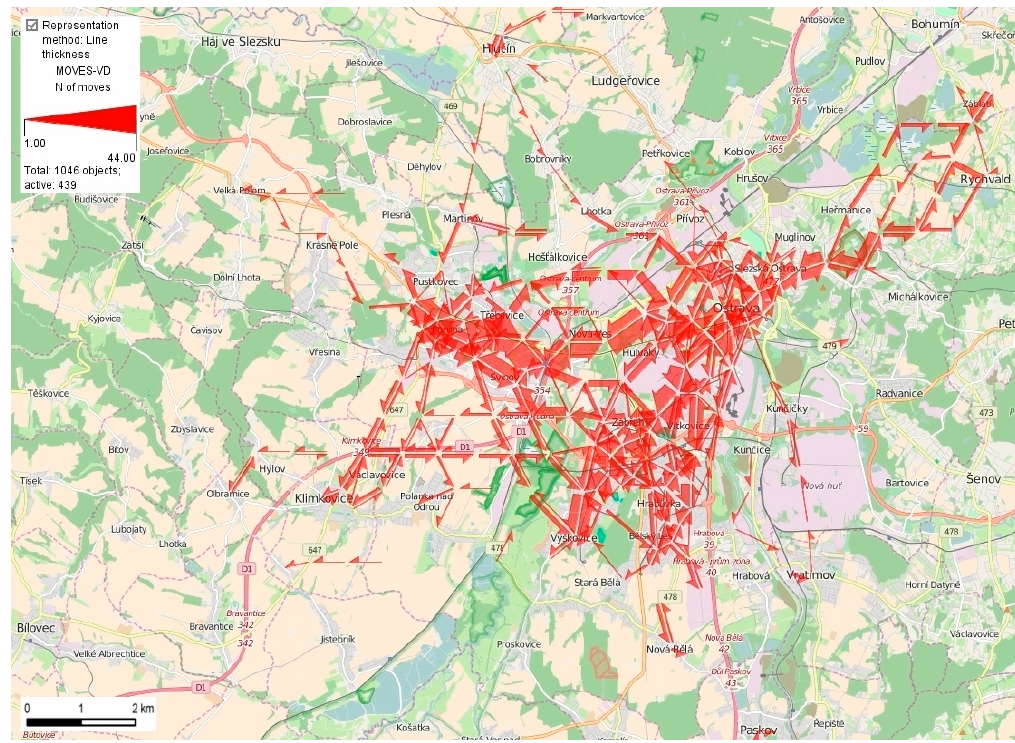
Figure 18. Dominant directions of movement in Ostrava according to public transport. Soc. Sci. 2018 , 7 , x FOR PEER REVIEW